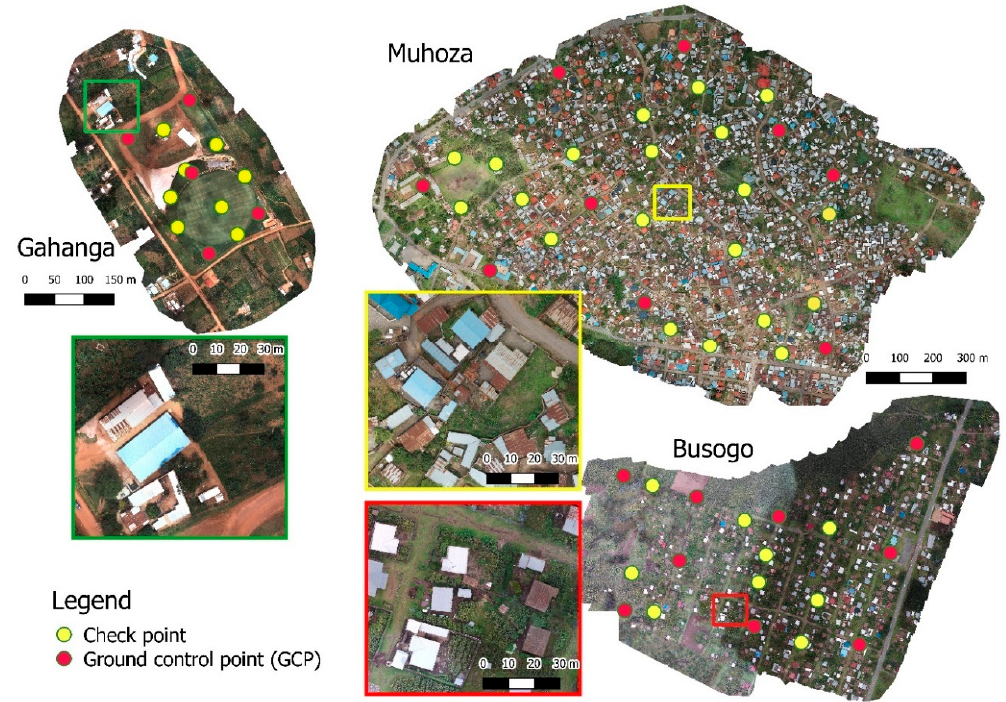
Figure 5. Overview of the generated orthomosaics and GCP/checkpoint distribution.